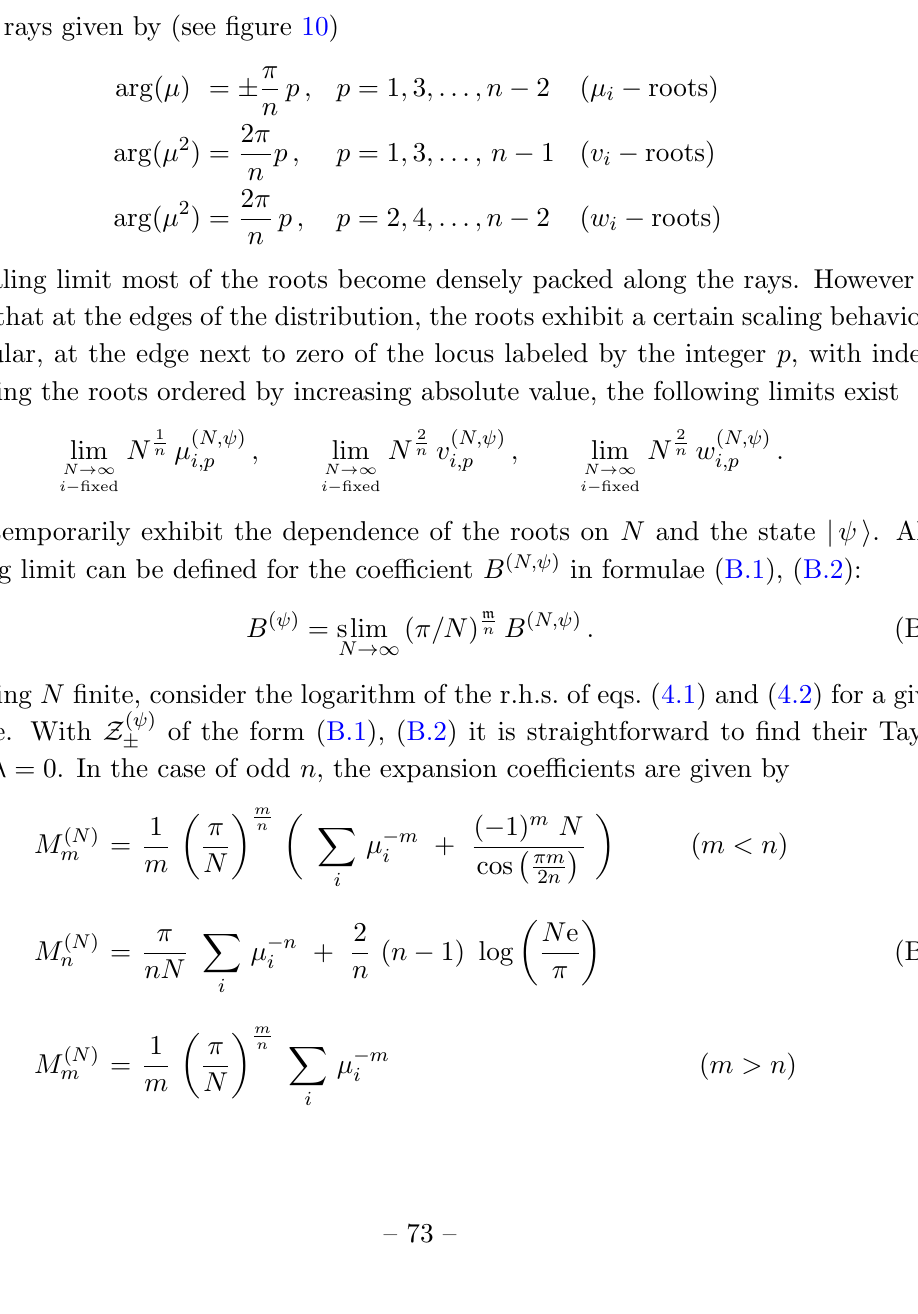
Figure 10 . On the left panel, the roots of Z (vac) j = 1 ; m = 0 and N = 12. On the right panel, the roots of Z (vac) functions of (cid:22) 2 are shown for n = 6, 2 j = 3 ; m = 1 and N = 8.